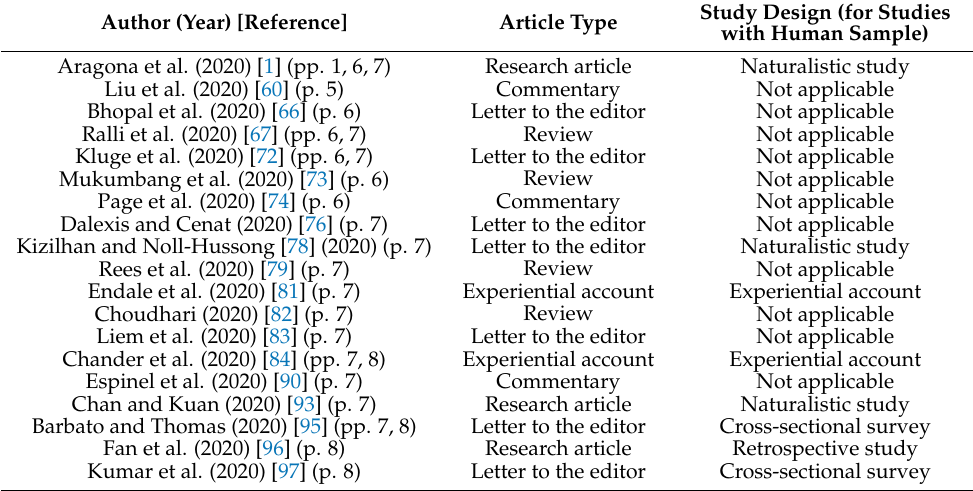
Table A2. Papers evaluating the relationship between migration, the COVID-19 pandemic and mental